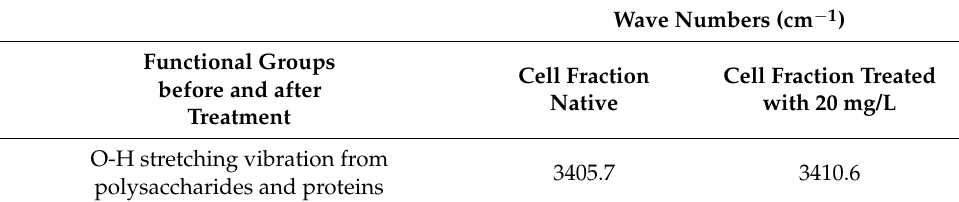
Table 2. FTIR spectrum analysis of the subcellular fraction before and after treatment with 20 mg/L of Cr (VI).